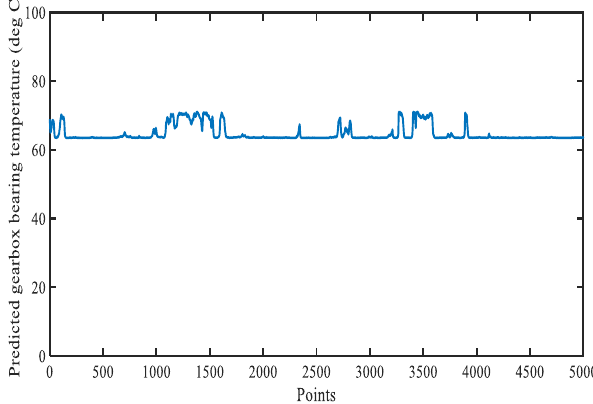
Figure 17. Actual temperature of the gearbox bearing gained from the SCADA model.